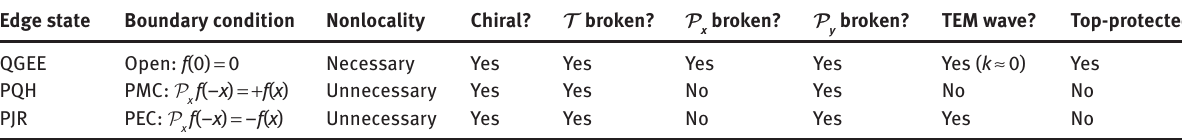
Table 1: Summary of the three unidirectional (chiral) photonic edge states arising in two-dimensional gyroelectric media, with their important properties listed.